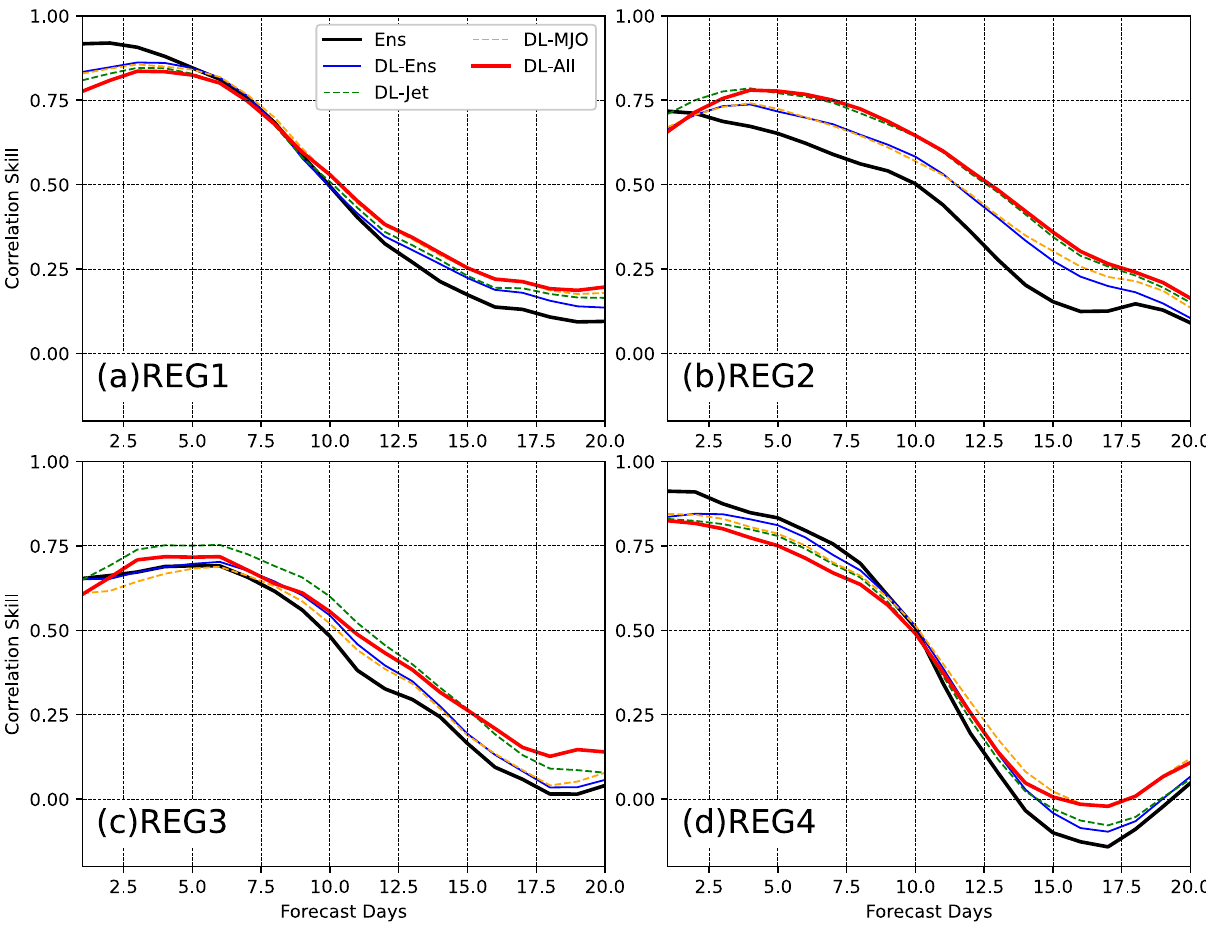
Figure 5. Time variations of R at four grid cells in the four regions marked in Figs. 3 and 4. The R values are presented during the first 20 forecast days. The solid black curve is the R for the direct mean of ensemble members. The solid blue, dash green, dash orange, and solid red lines are for DL-Ens, DL-Jet, DL-MJO, and DL-ALL, respectively. The y-axis and x-axis are for R and forecast days,